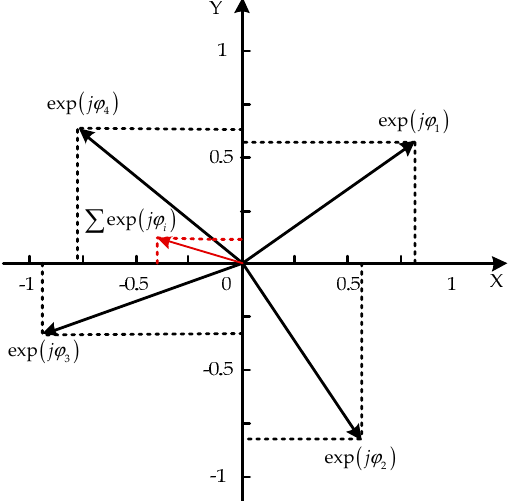
Figure 5. Sketch map of summation with equal section lengths and random phase situation. The black arrows represent the vectors of four sections after MPSM, and the red arrow represents the summation of black arrows.